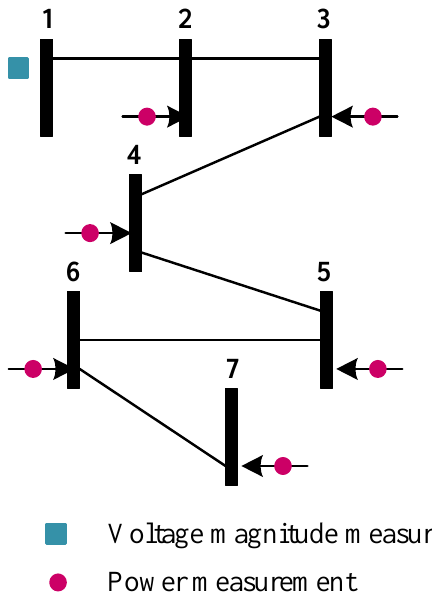
𝑖 = 1,2, … 𝑚. are correspond- 𝑖 ∈ [−1, 1] . 𝐾